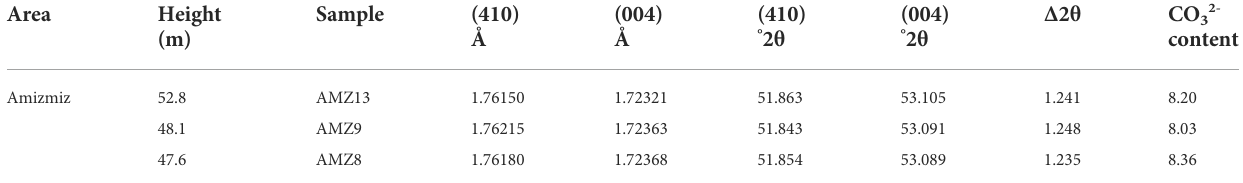
TABLE 1 XRD re fl ections and estimated CO 3 2- contents (wt.%) for the Amizmiz phosphorites. The carbonate concentration (wt.%) in CFA grains is calculated as 10.643x 2 − 52.512x + 56.986 where x stands for Δ 2 θ (004 – 410) (Schuffert et al., 1990). Area